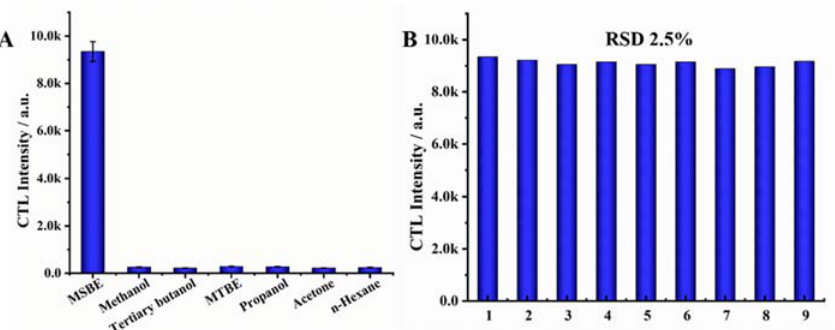
Figure 7. The selectivity ( A ) and repeatability ( B ) of 10 mg/L MSBE at Pt/Au NPs@Co 3 O 4.